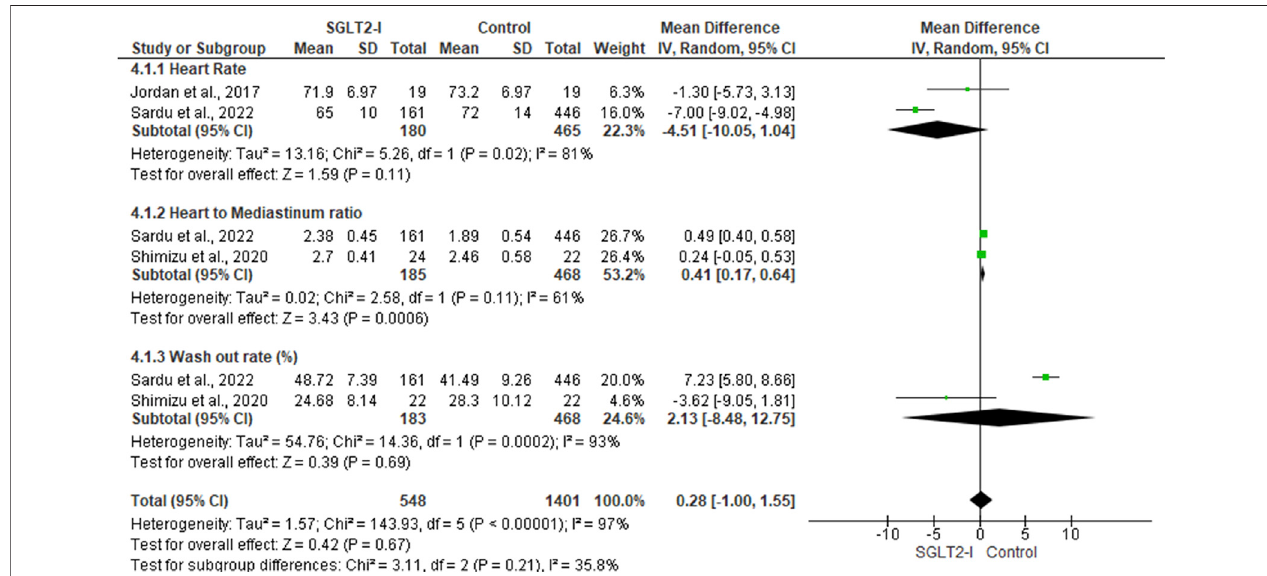
FIGURE 3 | Forest plot of summary analysis of the mean difference and 95% CI of the mean heart rate between SGLT2-I and control groups; the mean heart to mediastinum ratio between SGLT2-Iand control groups and the mean wash-out rate between SGLT2-I and control groups. Each trial ’ s statistical weight is represented by the size of the blue squares. The grey diamond represents the pooled point estimate. A signi fi cant outcome (IV = inverse variance) is indicated by the placement of diamonds and squares (together with 95 percent con fi dence intervals) beyond the vertical line (unit value).